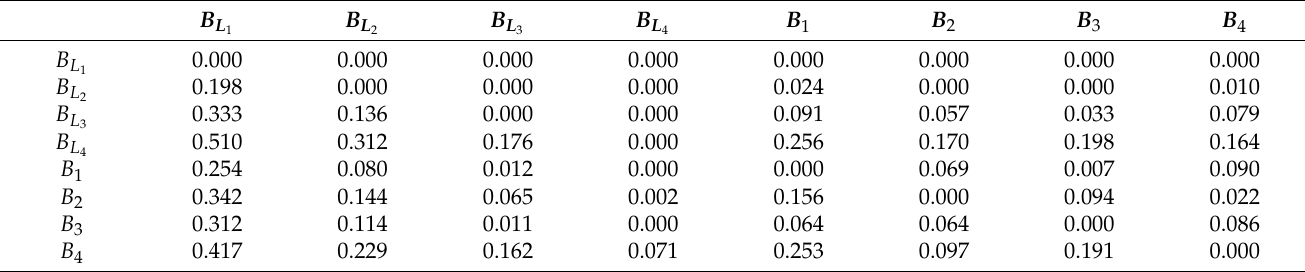
Table 8. Table 8. Average preference